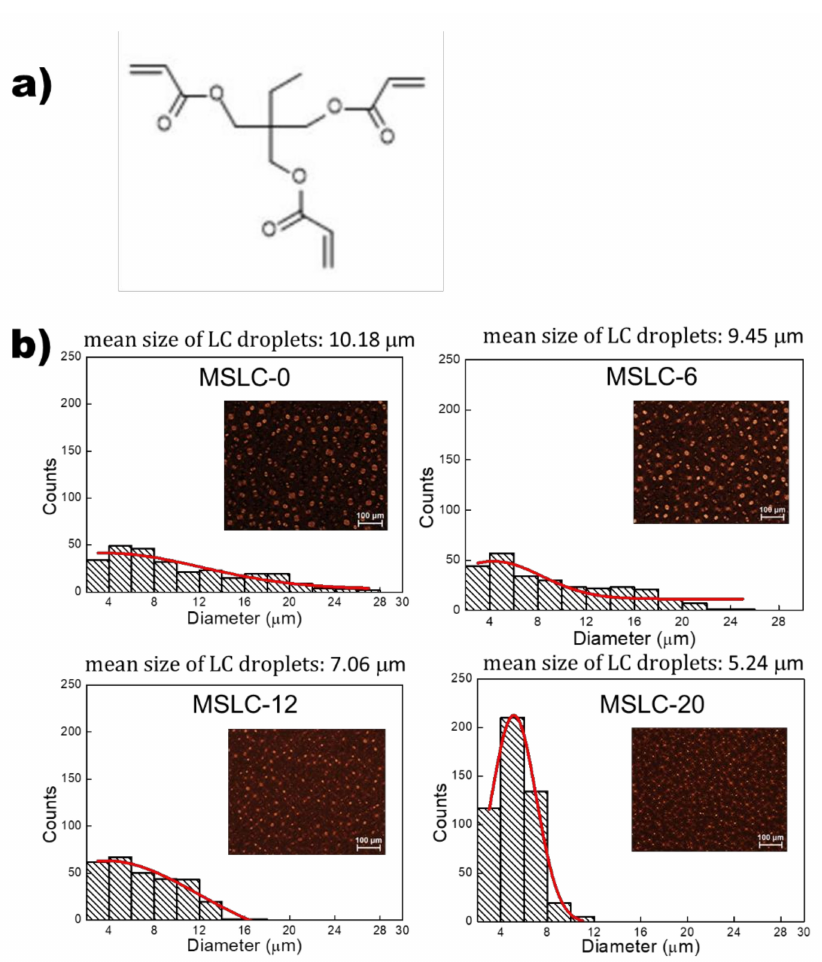
Figure 1. ( a ) Chemical structure of the multi-functional acrylate TMPTA. ( b ) Histograms of the LC droplet size distribution in the MSLC-0, MSLC-6, MSLC-12, and MSLC-20 films, respectively. Typical POM images of the four films are also provided in the